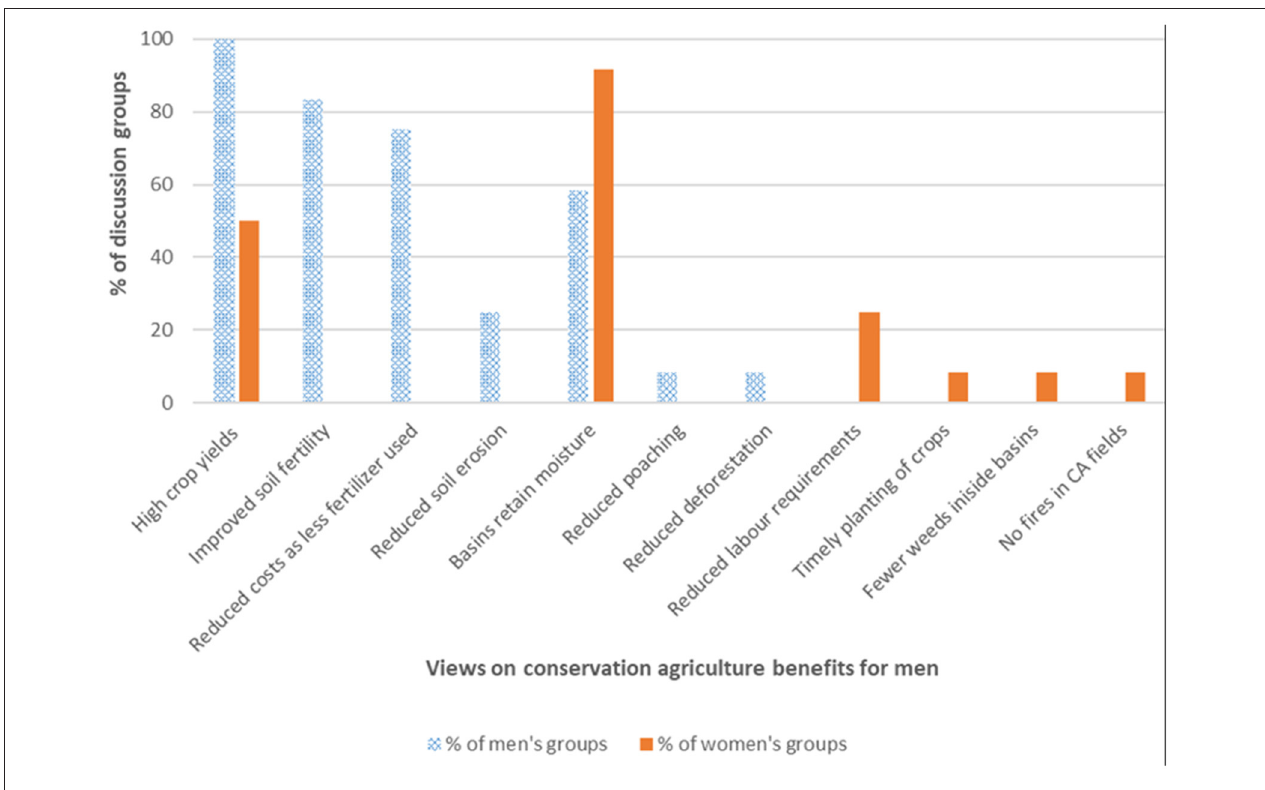
FIGURE 9 | Perceptions on benefits of CA for men.